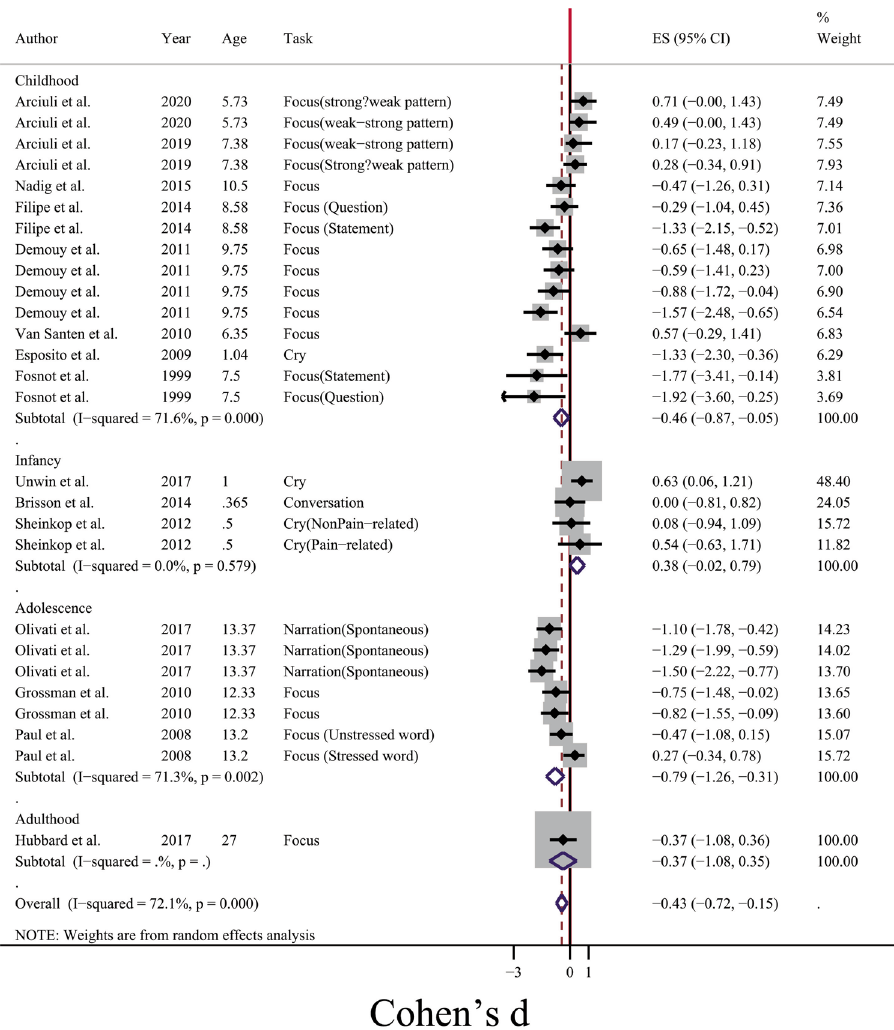
Figure 4. Forest plot for the subgroup meta-analysis of the difference of voice duration between ASD and TD groups. The confounding factor for this analysis was the age span of participants.